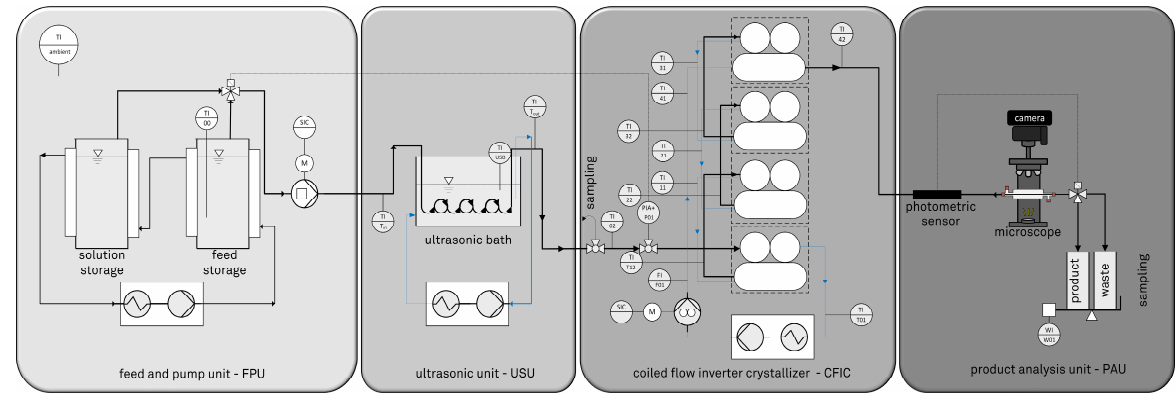
Figure 2. Flowchart of the crystallization process setup .